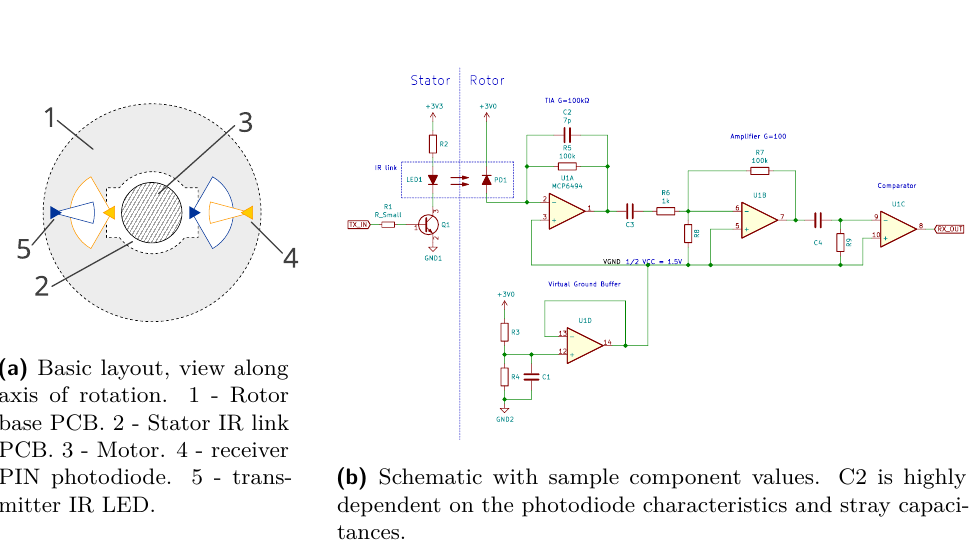
Figure 7: IR data link